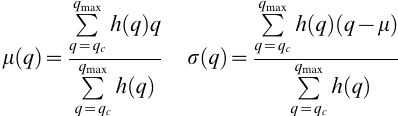
q c is a cut-off value given by the global minimum between the first and the second modes, when the histogram is bimodal, or the first local minimum of the histogram, when it is unimodal, and q max is the maximum grey level of the histogram. The threshold is obtained from the standard score (z-score), which rejects the outliers of the Gaussian function. The z-score is given by